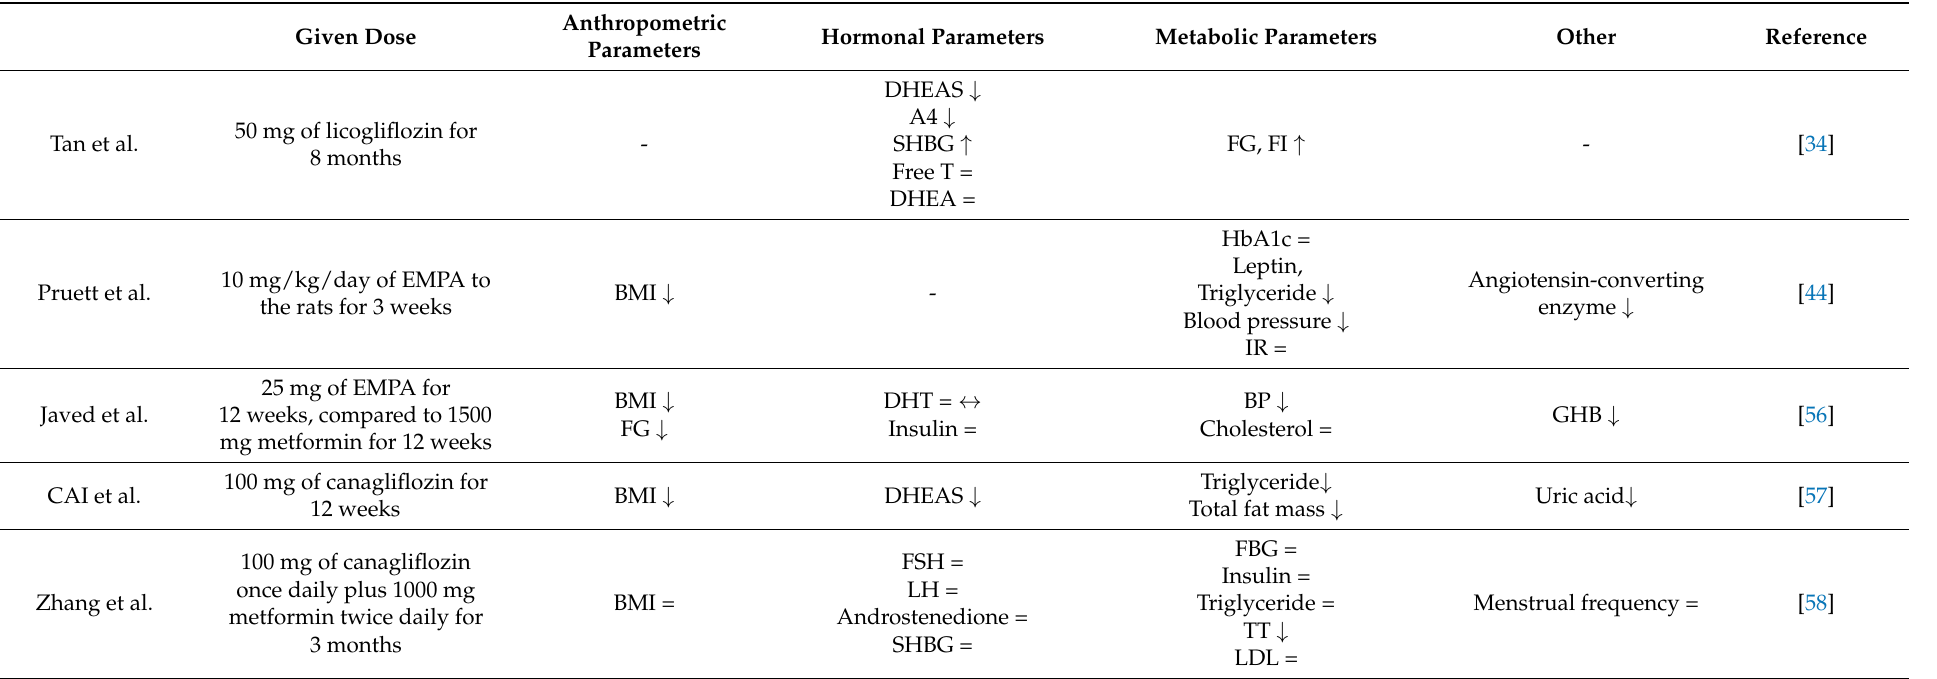
Table 1. The effects of different SGLT-2is on anthropometric, hormonal, and metabolic parameters. Anthropometric Given Dose Hormonal Parameters Metabolic Parameters Other Parameters